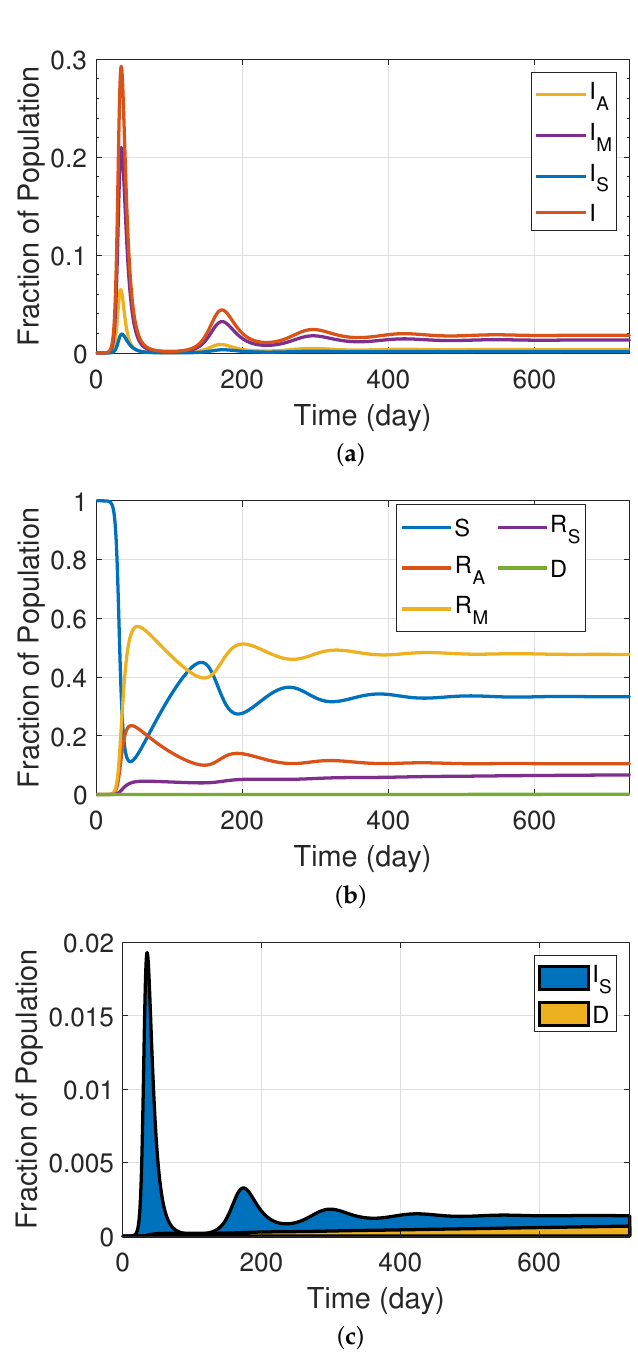
Figure 4. SIRS model with different levels of severity (model depicted in Figure 3). ( a ) Fraction of infectious population in asymptomatic, mild, and severe classes; ( b ) fraction of susceptible and recov- ered population in different groups; ( c ) fractional population of death compartment in comparison with severe